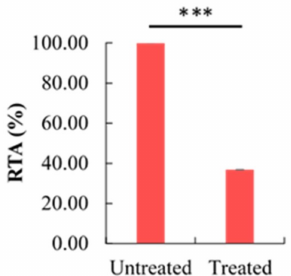
Figure 5. Effect of 10.54 µ g/mL berberine-treated HCT 116 at 48 h on relative telomerase activ- ity (RTA). Values are mean ± standard error of triplicate. Means with *** (triple asterisks) differ significantly at p <